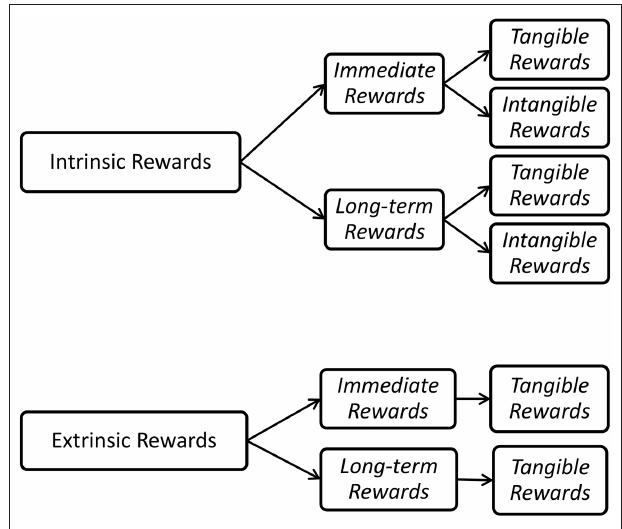
FIGURE 3 | Reward